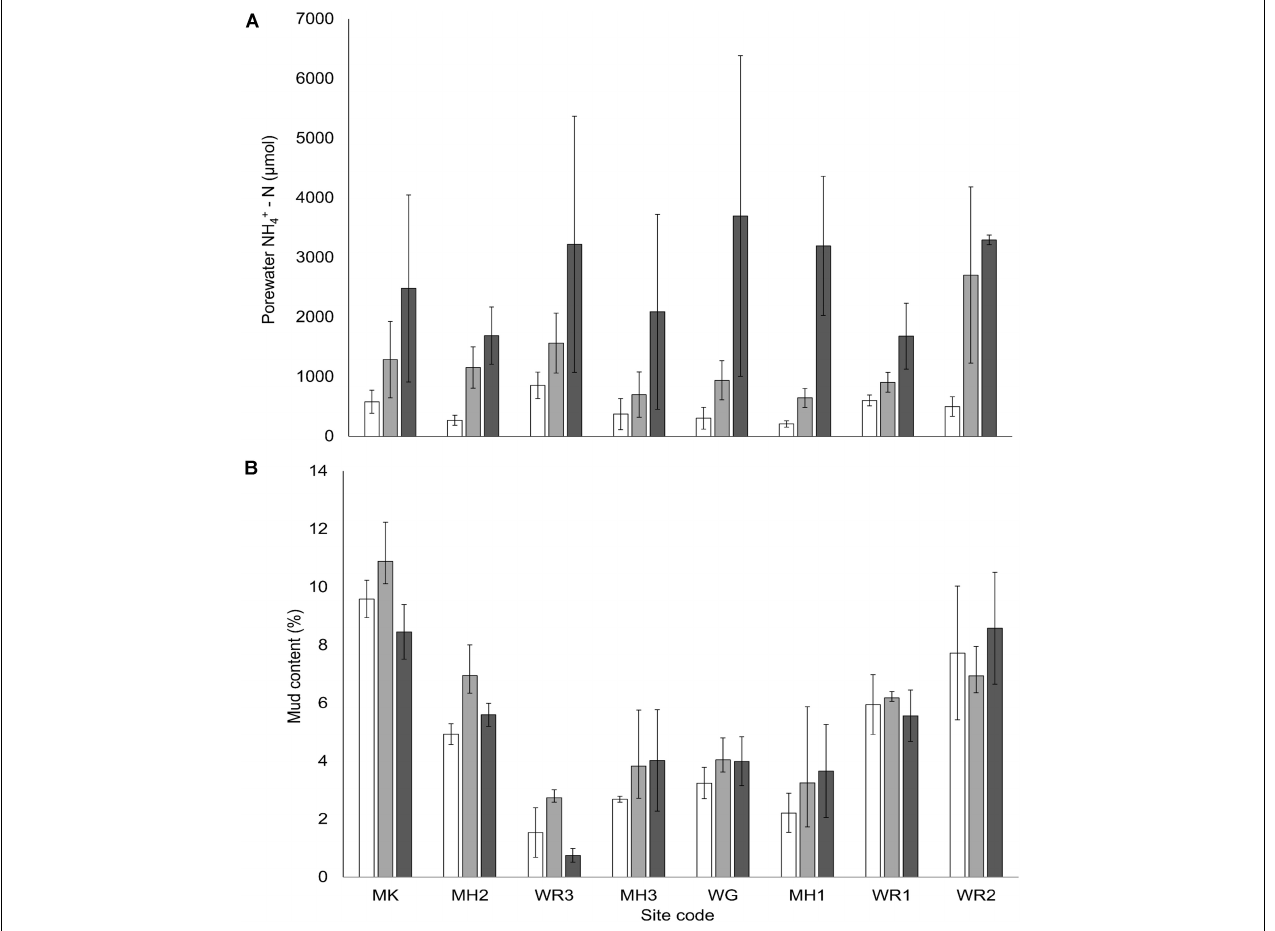
FIGURE 3 | (A) Mean porewater NH 4 + -N concentration ( µ M, ± SE, n = 3) of surface sediment (0–2 cm depth) for each treatment at each site. (B) Mean mud content (%, ± SE, n = 3) for each treatment at each site, and nutrient treatment. Nutrient addition treatments; white bars – control plots (0 g N m - 2 addition), light gray – medium plots (150 g N m - 2 addition and dark gray – high plots (600 g N m - 2